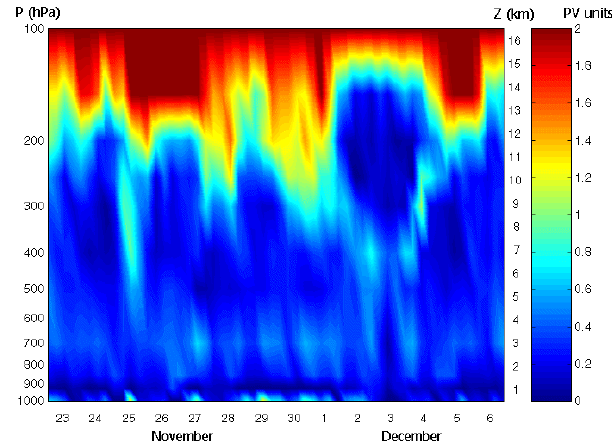
Figure 12 Fig. 12. Evolution of the profiles of potential vorticity as a func- tion of pressure level, over Reunion Island from 23 November to 6 December 1999 from ECMWF data. The right scale shows the approximate correspondence between pressure levels and